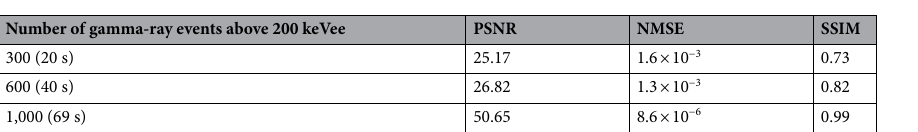
Table 2. Gamma-ray image quality evaluated by using PSNR, NMSE, SSIM as increasing measurement time or the number of counts.